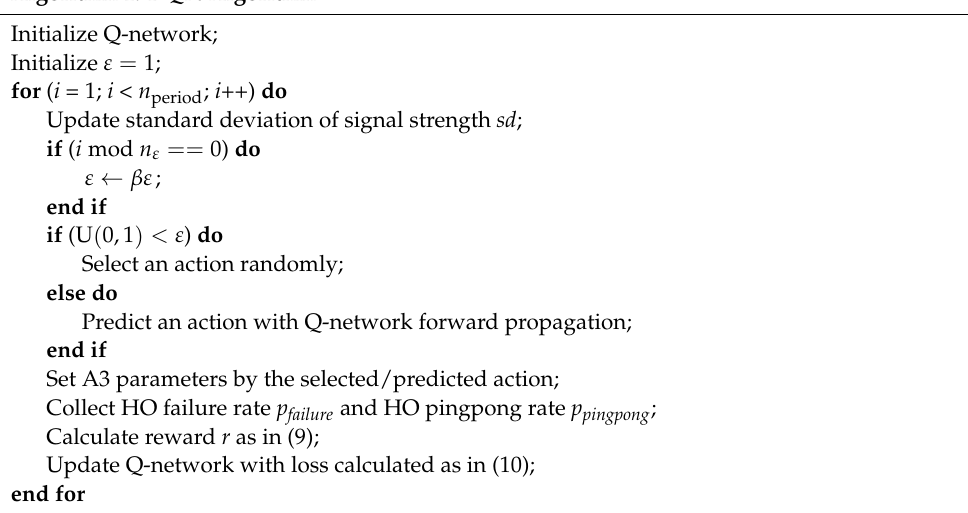
Algorithm 1. DQN Algorithm